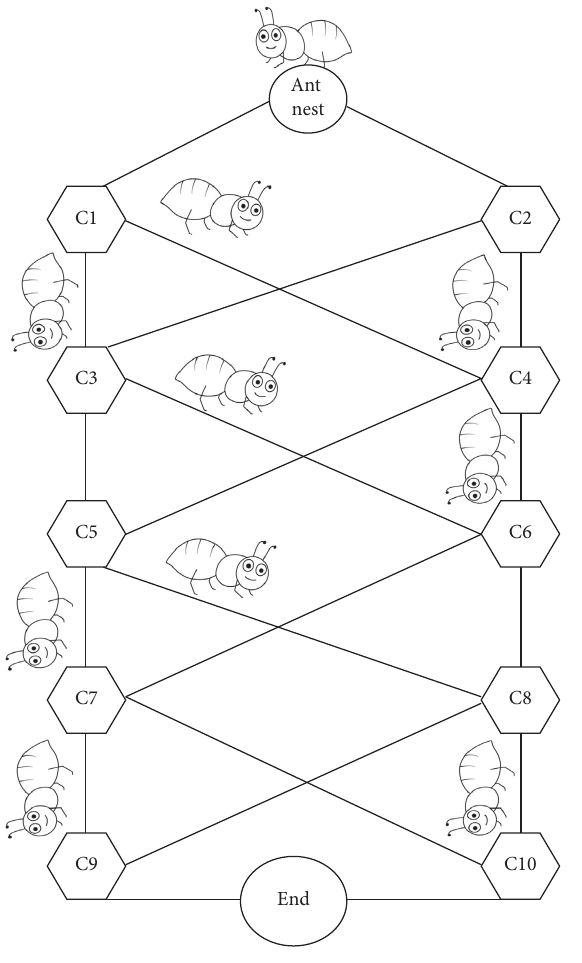
Figure 2: Ants traversals.